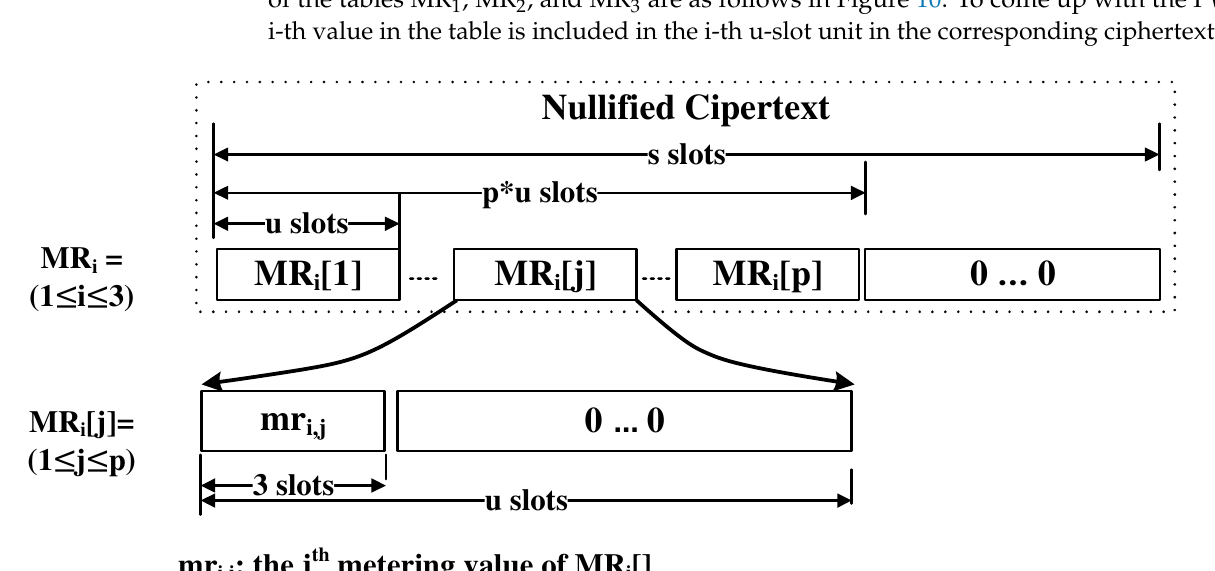
Figure 10. Length–strength matcher table.